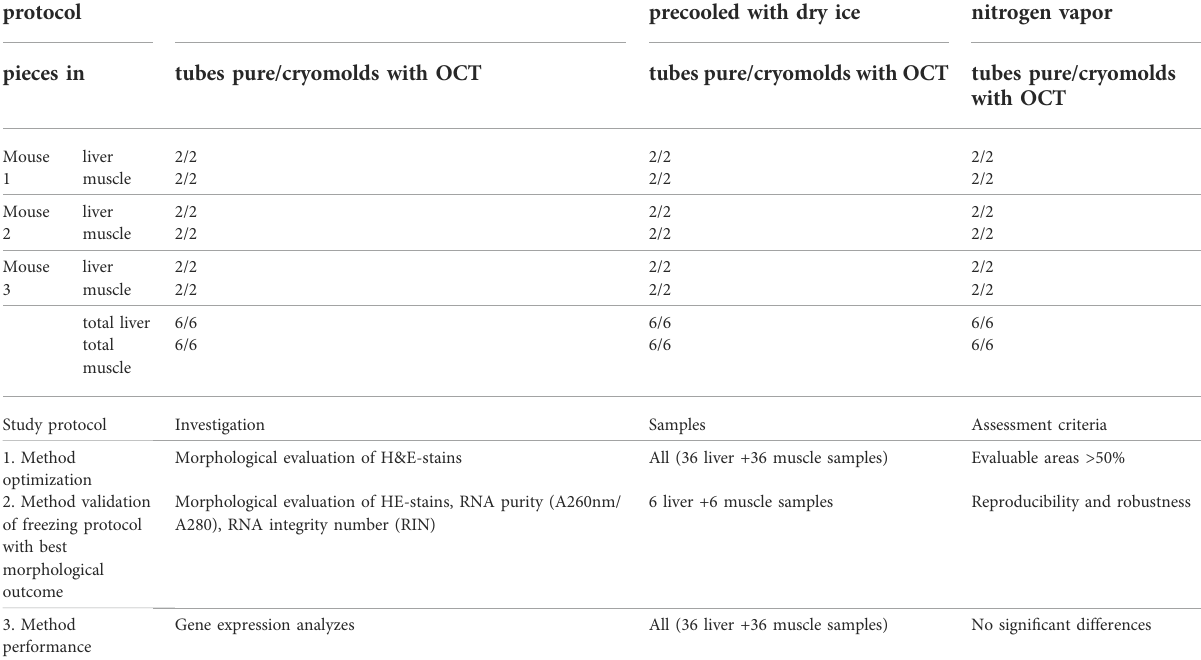
TABLE 1 Sample collection and experimental